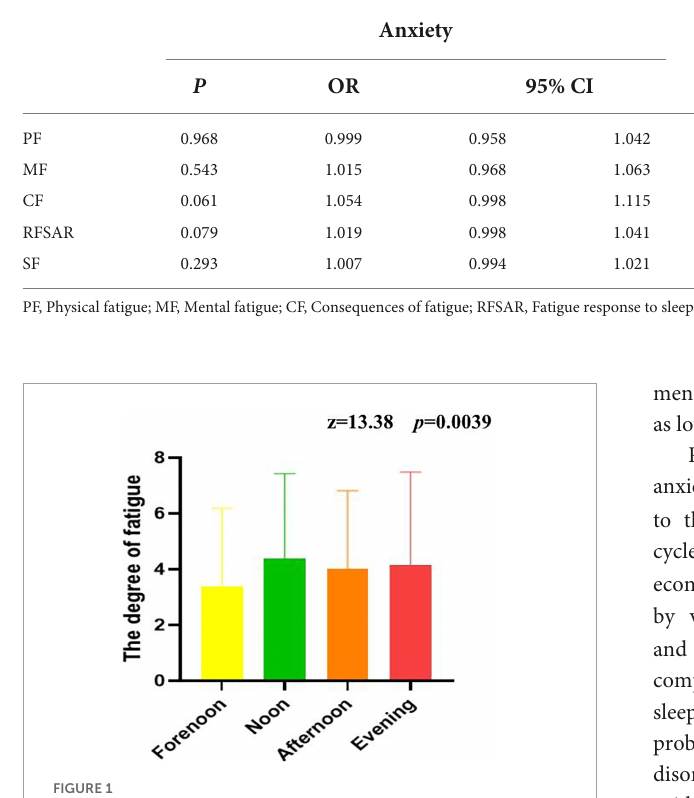
TABLE 6 Binary logistics regression of fatigue factor among anxiety and depression.